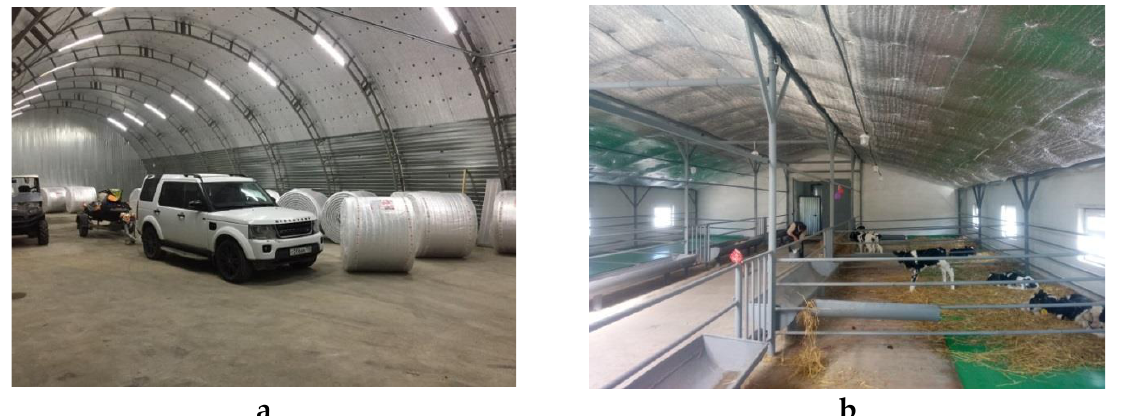
Figure 11. Insulation of technological objects: ( a ) — insulation of parking lot (frameless building); ( b ) — covered cattle yard (framed building).